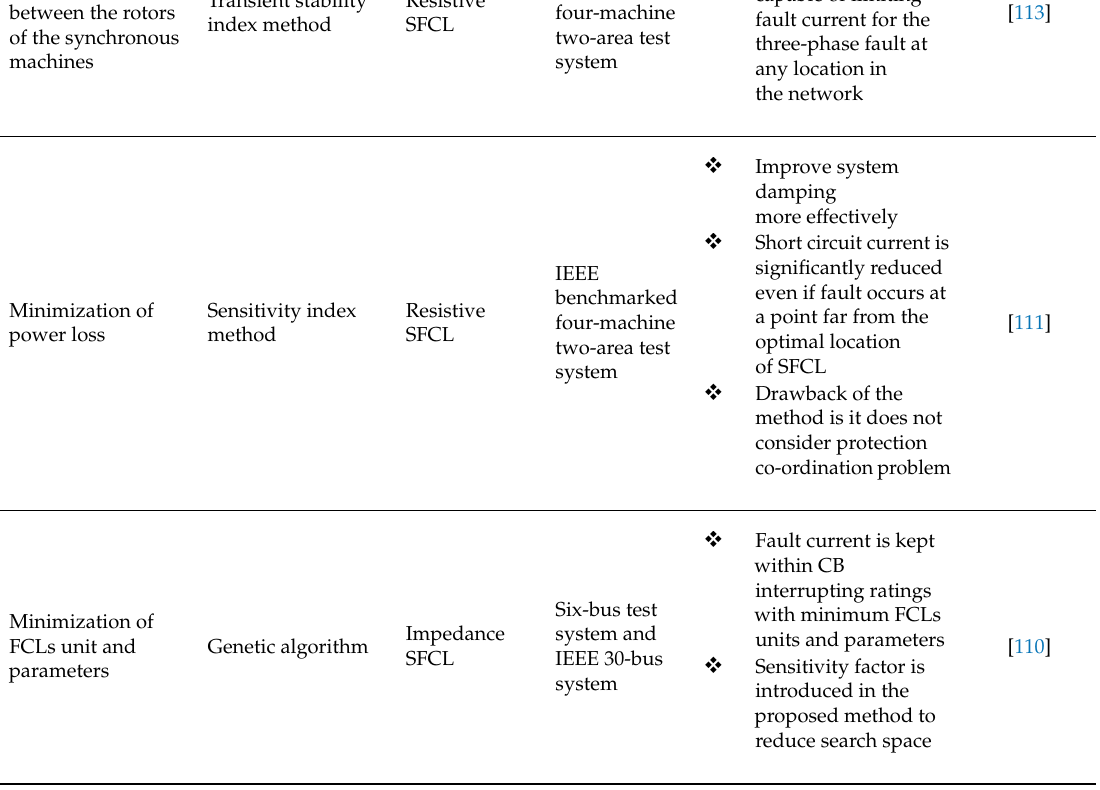
Figure 4. The phases for implementing a N-AHP in SWOT analysis.